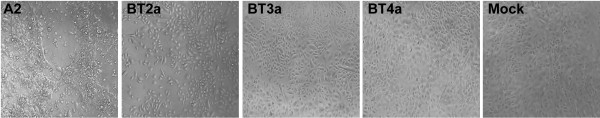
RSV A2 induces more cytopathic effects (CPE) than the 3 clinical isolates. PBECs from 5 individual donors were infected with RSV A2, BT2a, BT3a and BT4a (MOI of 0.1) during 2 h and washed with PBS. Seventy two hpi, cells were examined by phase contrast microscopy. Micrographs of a representative field for each RSV strain are presented. PBECs infected with RSV A2 demonstrated substantial CPE, whereas cells infected with RSV BT2a and BT3a displayed only limited CPE. Cells infected with RSV BT4a did not demonstrate any obvious CPE and were similar to non-infected cultures. Original magnification, x10.